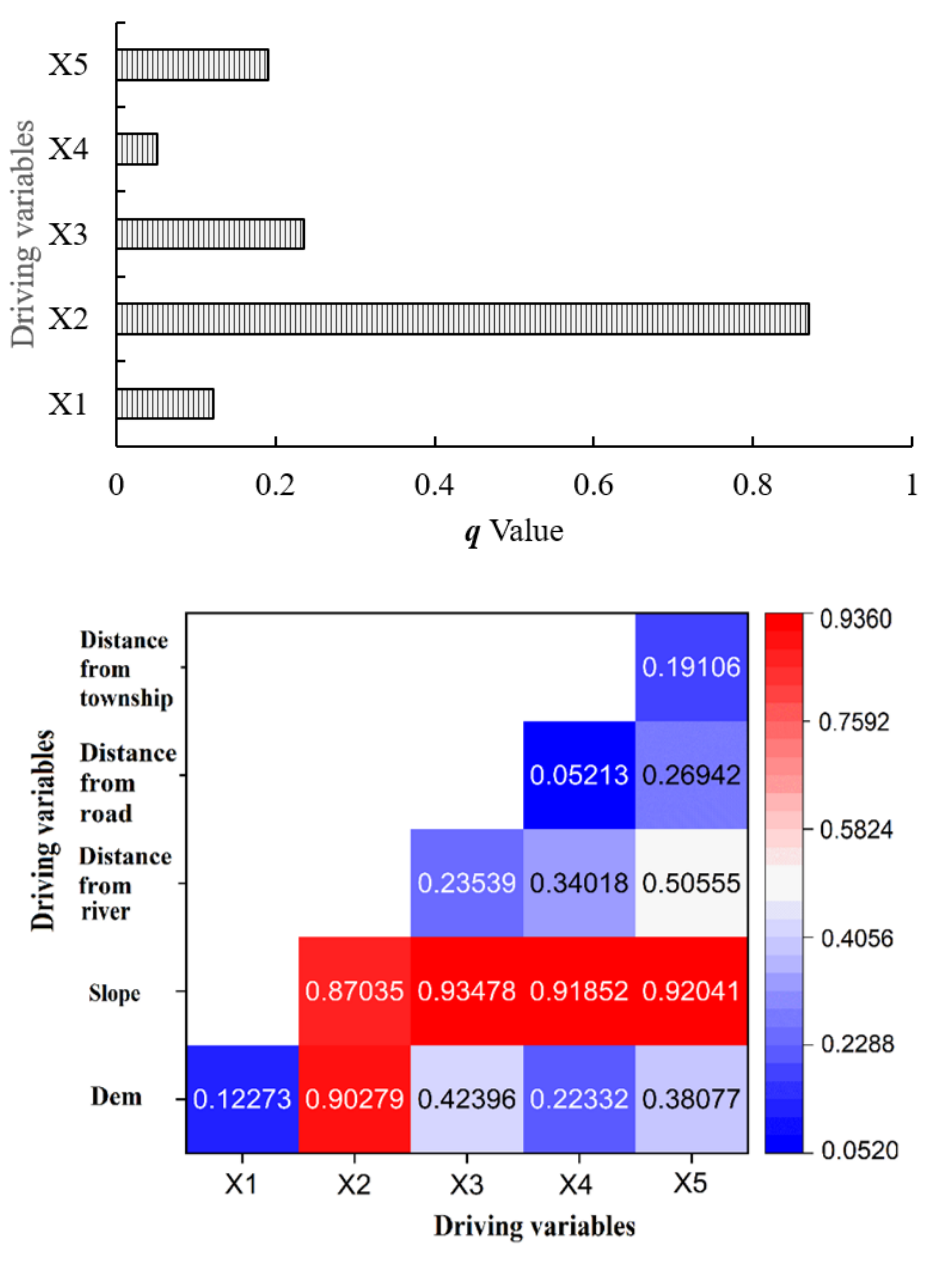
Figure 7. Results of single-factor detection and double-factor interaction detection of Geodetector.